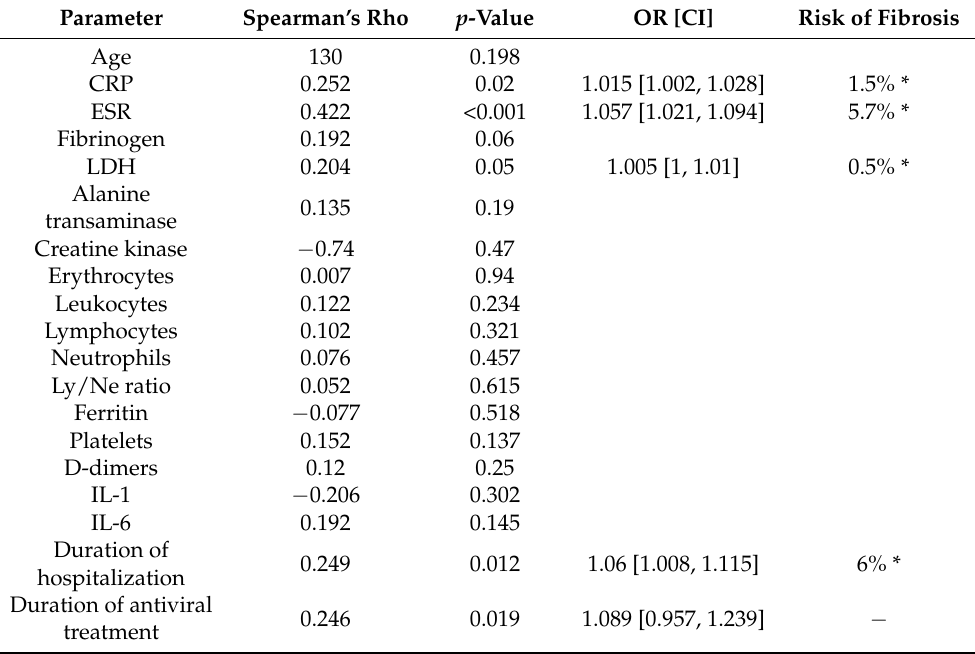
Table 3. Risk factors associated with pulmonary fibrosis in patients at hospital